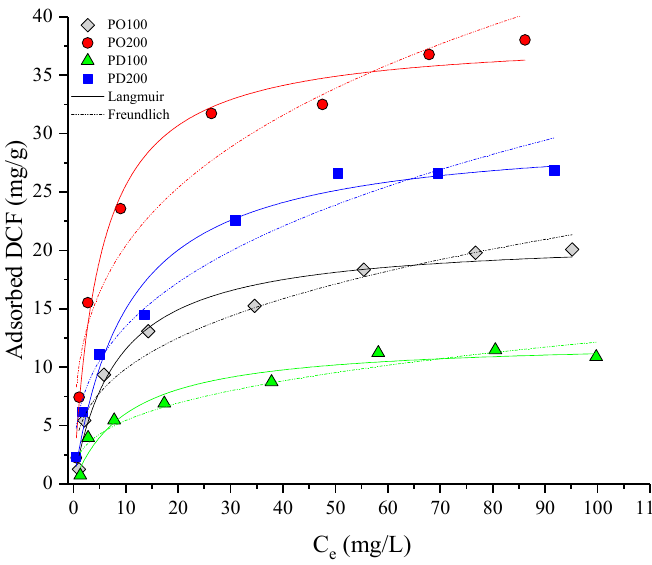
Figure 3. Equilibrium isotherms of DCF adsorption on composites of P.